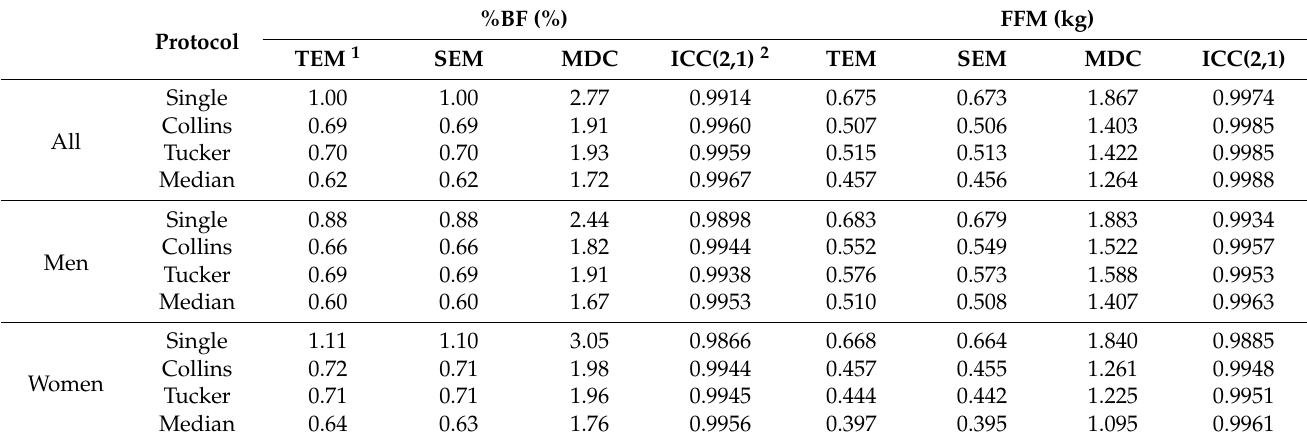
Table 4. Statistical measures of test–retest reliability of %BF and FFM